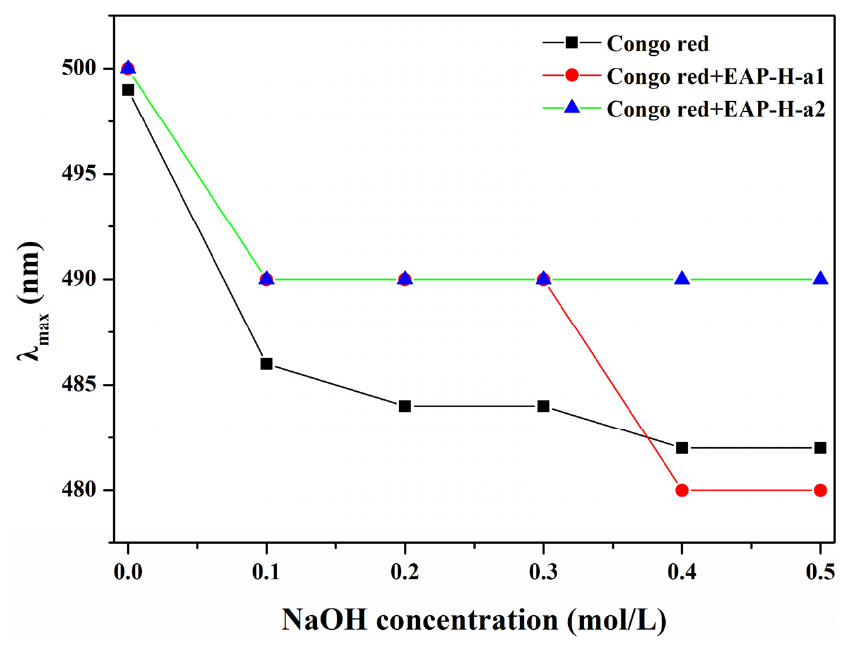
Figure 4. Congo red analysis of the polysaccharides.